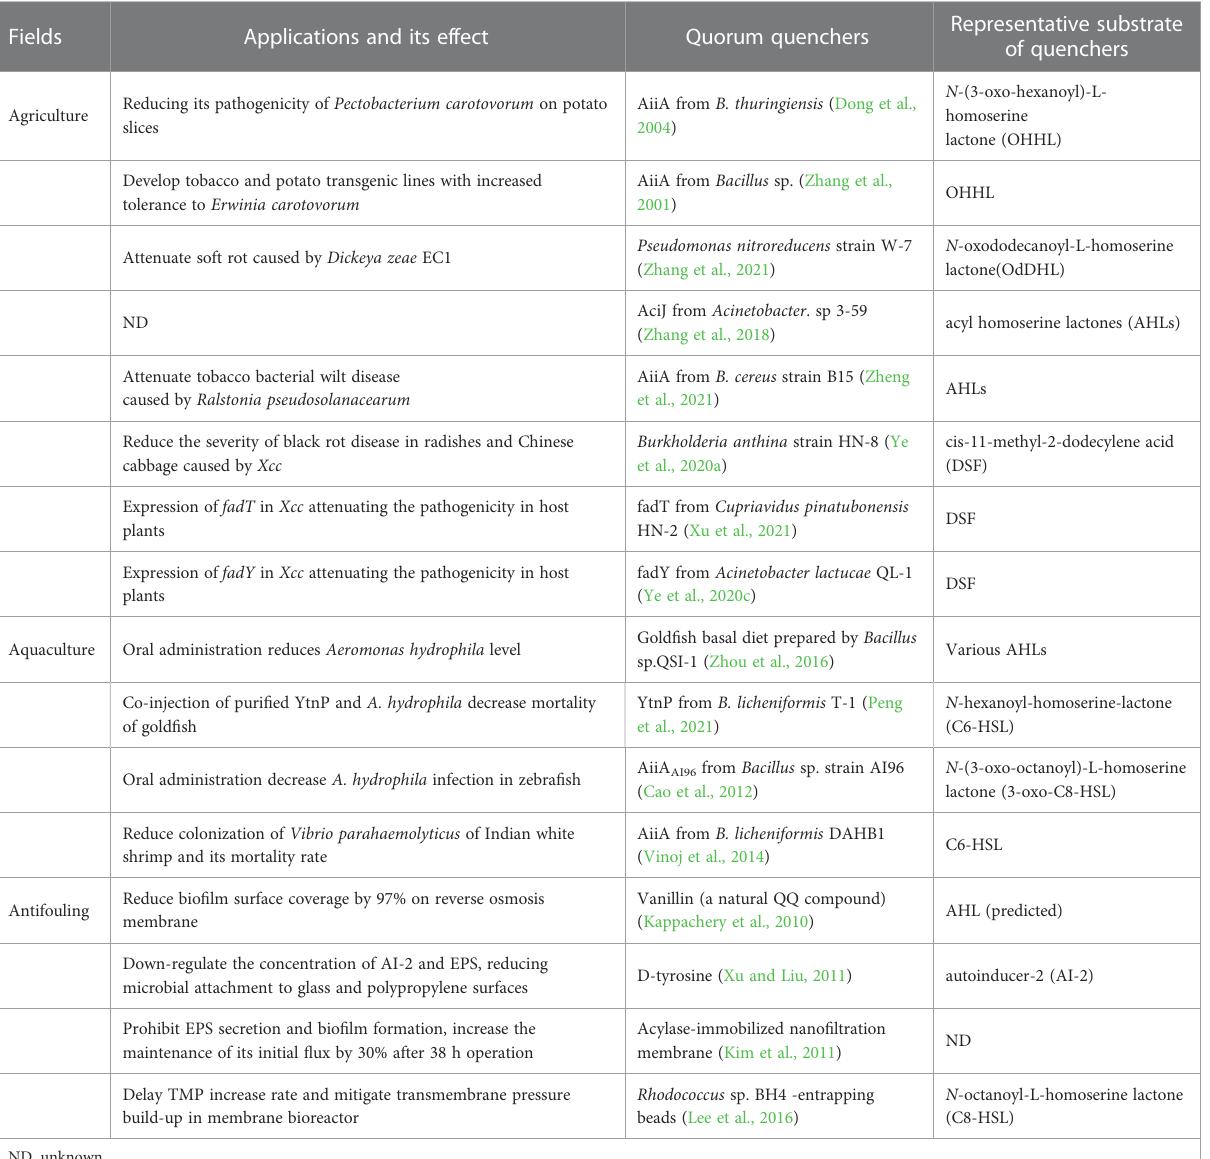
TABLE 2 Quorum quenchers isolated from various sources and their